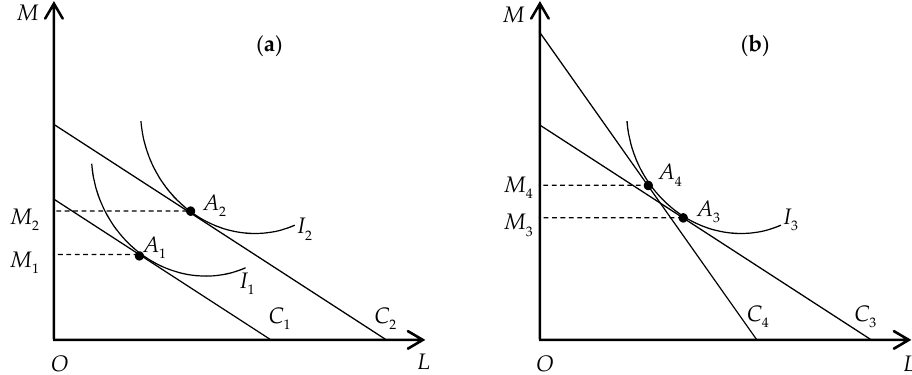
Figure 1. Influence mechanism of rural–urban migration experience on agricultural machinery expenditure. ( a ) describes the impact mechanism of rural–urban migration experience on agricultural machinery expenditure through increasing farmers’ income and wealth; ( b ) describes the impact mechanism of rural–urban migration experience on agricultural machinery expenditure through increasing the expected price of labor relative to agricultural machinery.